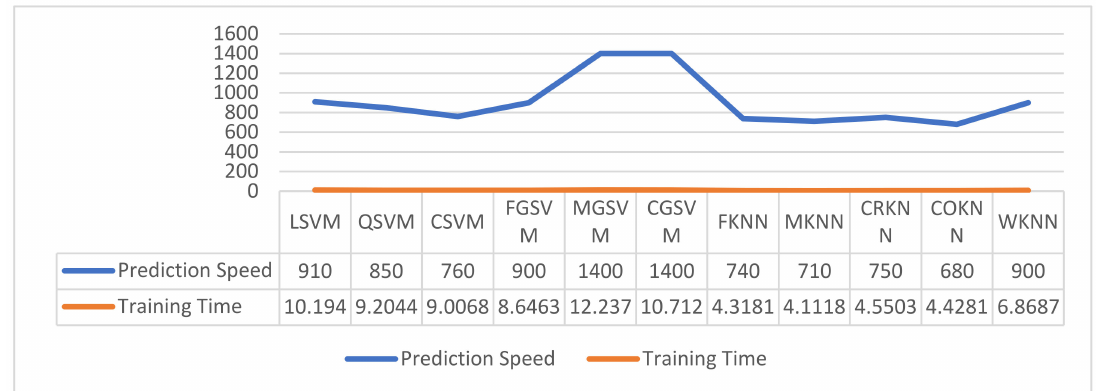
Figure 6. Proposed model training time (s) and prediction speed (obs/s) on front views of MIT dataset utilizing 1000- feature subset.